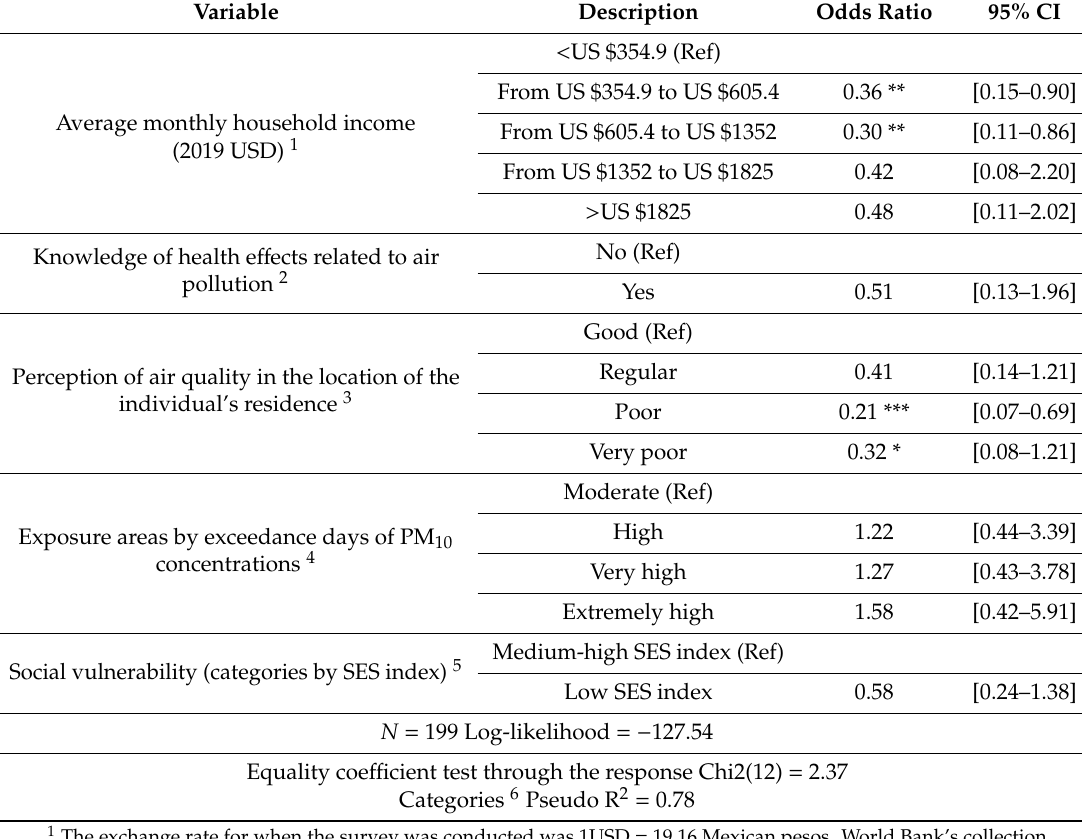
Table 2. Estimates for the perceived changes in air quality (worsened, unchanged, improved) on